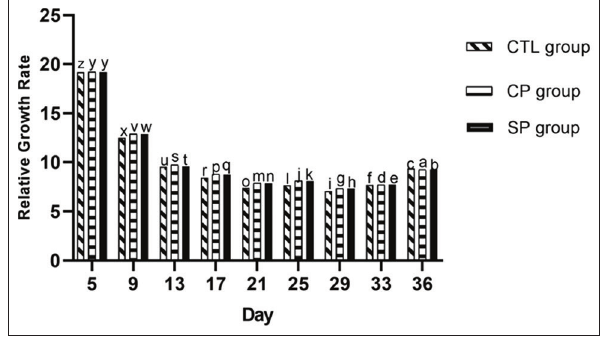
Figure-2: Relative growth rate of broilers fed basal diets supplemented with antibiotic (CTL group), commercial probiotic Protexin ® (CP group), and study probiotic mixture (SP group). Values are the RGR at every 4 th days’ interval. Within each day, different letters indicate significant difference in values at p < 0.05 (ANOVA, Duncan’s MRT).